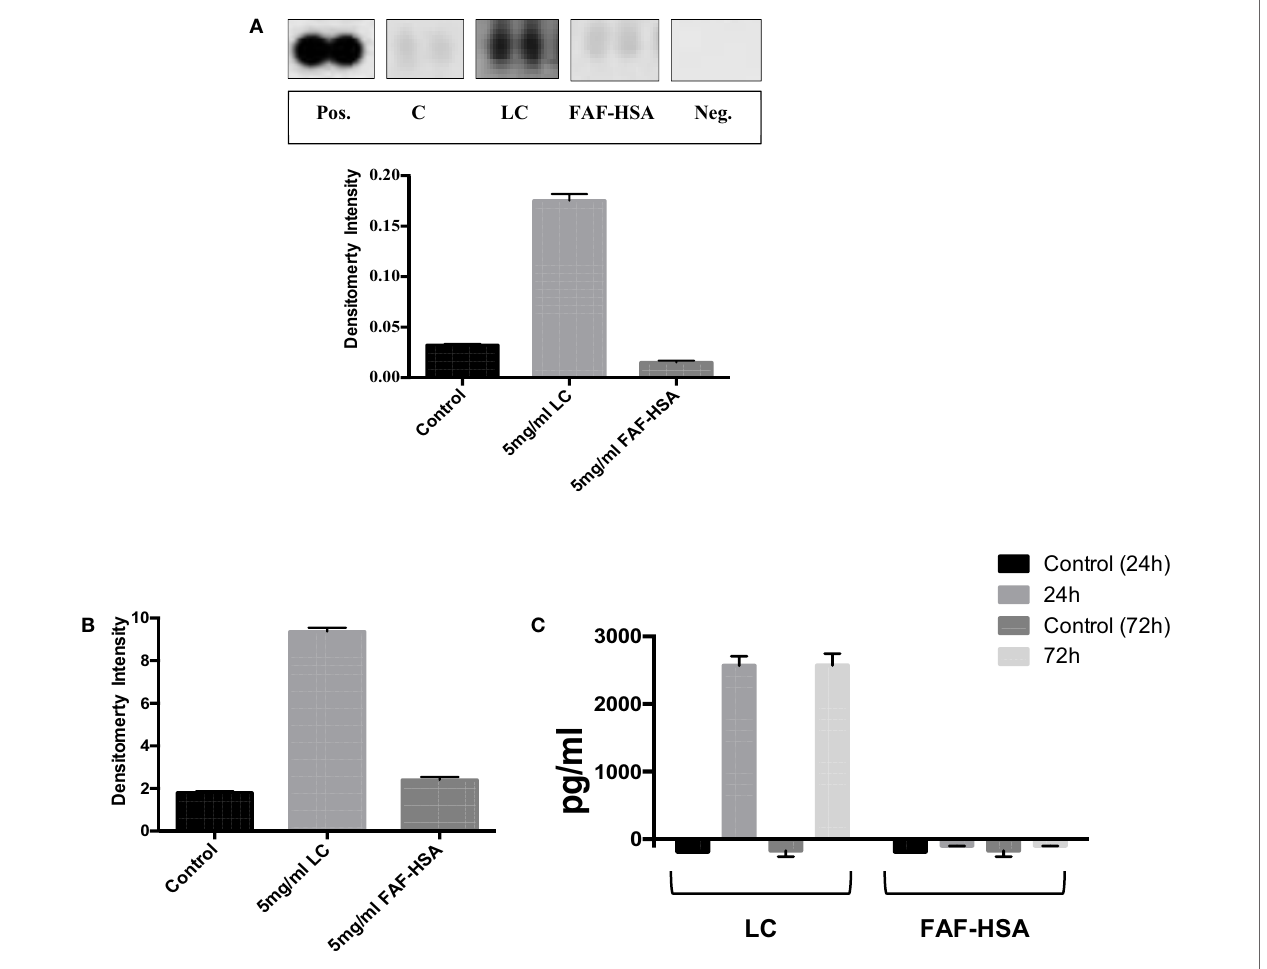
FiGUre 2 | the human kidney biomarker array (r&D systems) was used to analyze tFF3 abundance in lysates from cells exposed to immunoglobulin λ light chain (Lc) and fatty acid free human serum albumin (FAF-HsA) for 72 h in comparison with control cells (A) . Densities were normalized to a reference (pos), background subtracted and are expressed as ± SD. (B) Abundance of TFF3 (in relation to β -actin) in cell lysates from HK-2 cells exposed 5 mg/ml immunoglobulin λ light chain (LC) or fatty acid-free human serum albumin (FAF-HSA) for 72 h (Western blot). (c) ELISA of TFF3 in the supernatants of HK-2 stimulated with 5 mg/ml LC and FAF-HSA. Untreated cells were used as control. Two independent experiments for the distinct stimulations for 24 and 72 h are